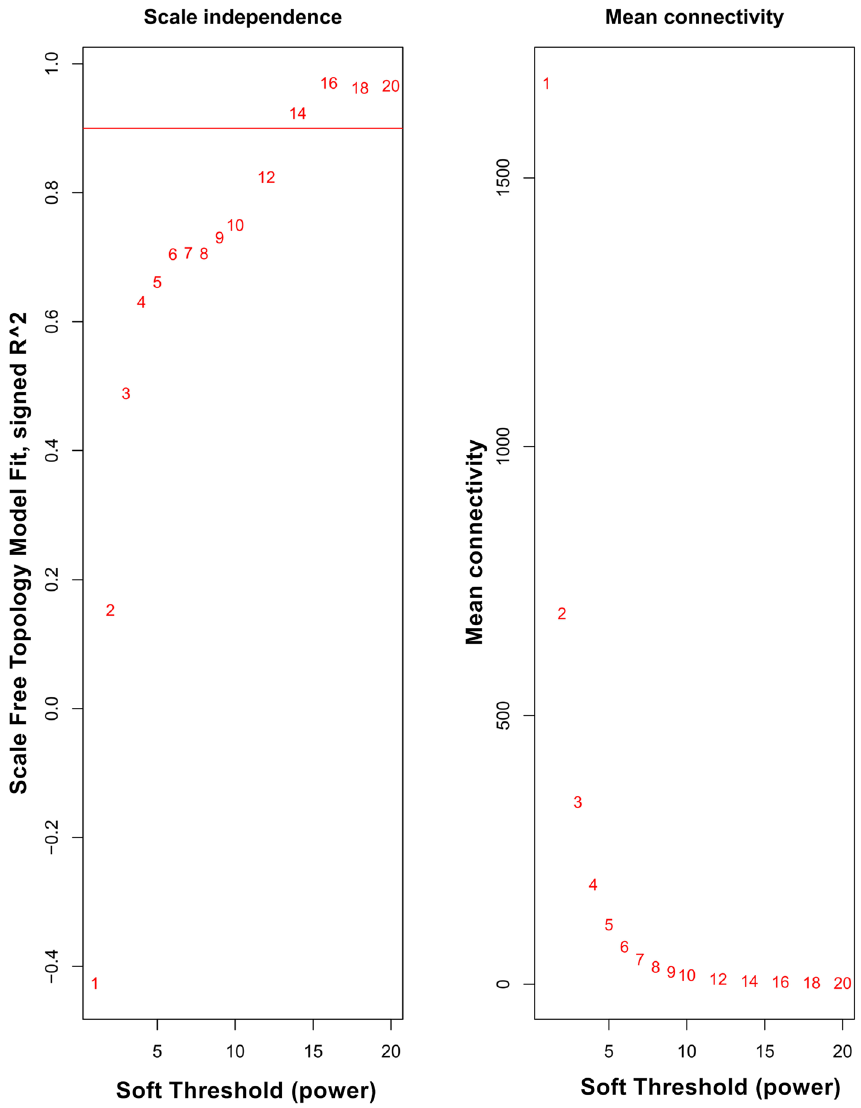
Figure 1. Analysis of network topology for various soft-thresholding powers. The left panel shows the scale- free fit index (y-axis) as a function of the soft-thresholding power (x-axis). The right panel displays the mean connectivity (degree, y-axis) as a function of the soft-thresholding power